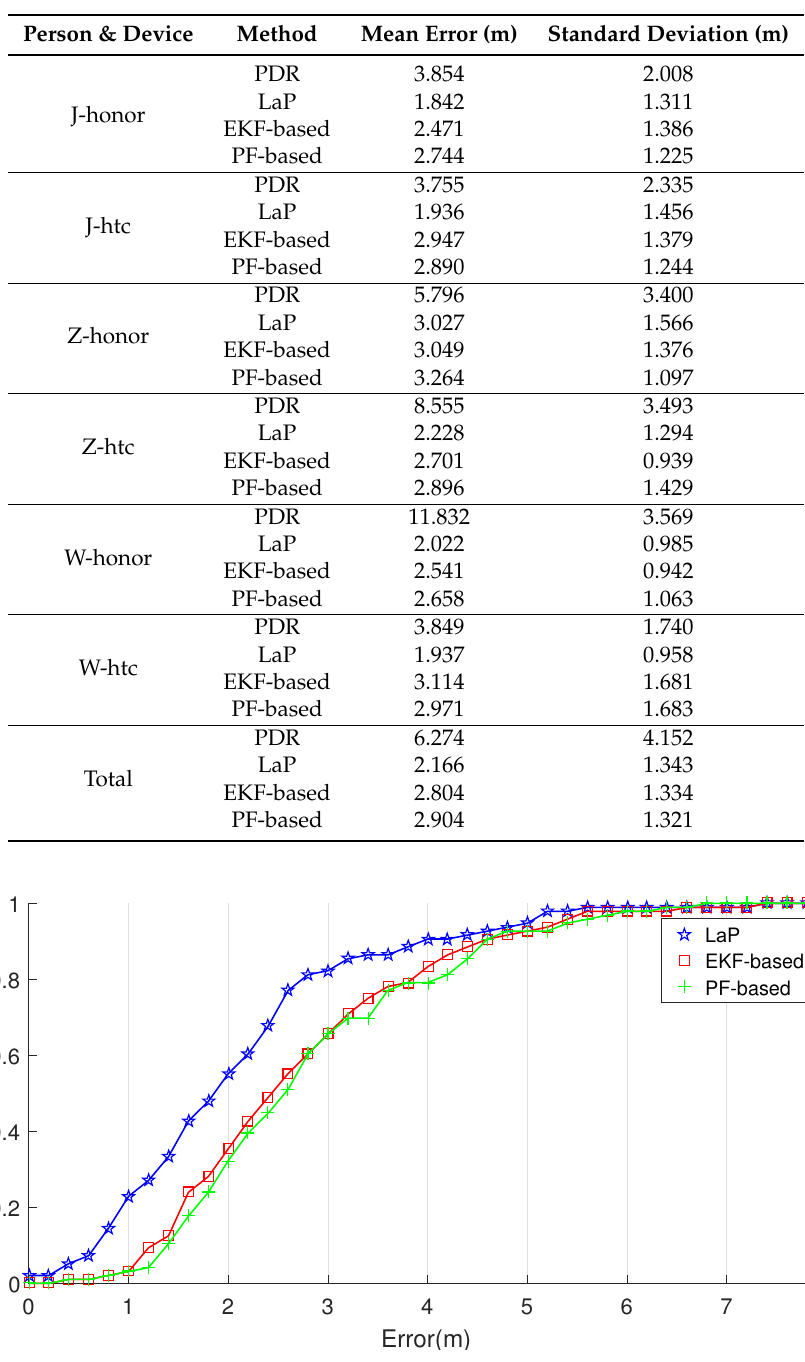
Table 3. Position errors of LaP and other multi-fusion approaches.